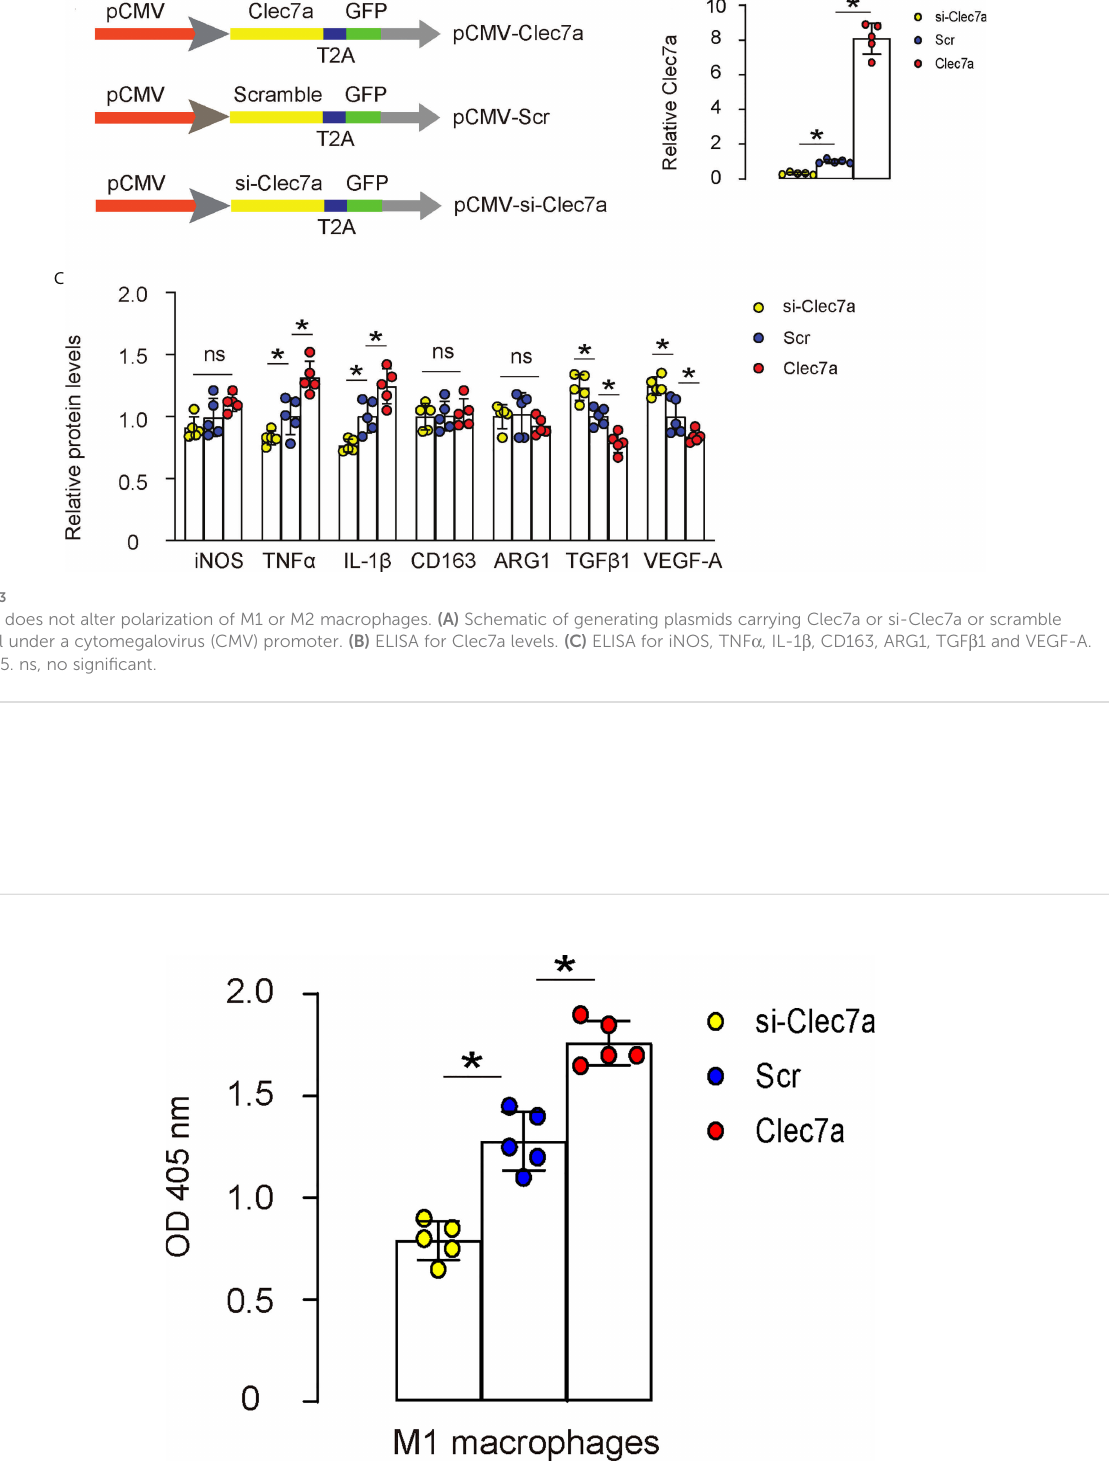
FIGURE 4 Clec7a increases phagocytic potential of M1 macrophages. A phagocytosis assay using Clec7a or si-Clec7a transfected LPS/IFN- ɣ -primed M1 macrophages.